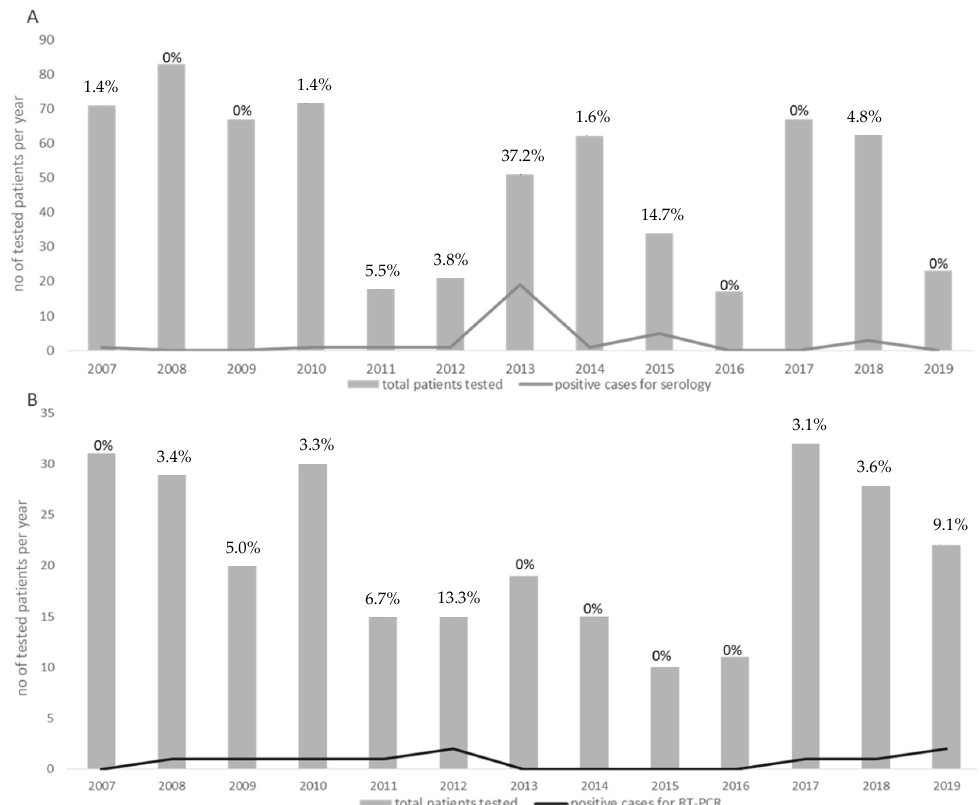
Figure 1. Annual distribution of the total number of patients tested between 2007 and 2019 (grey boxes). The number of positive cases diagnosed during each year is indicated by grey lines. The number of positive cases for serology and for RT-PCR is given in ( A , B ), respectively. Percentages of positive cases per each year are given in each graph.